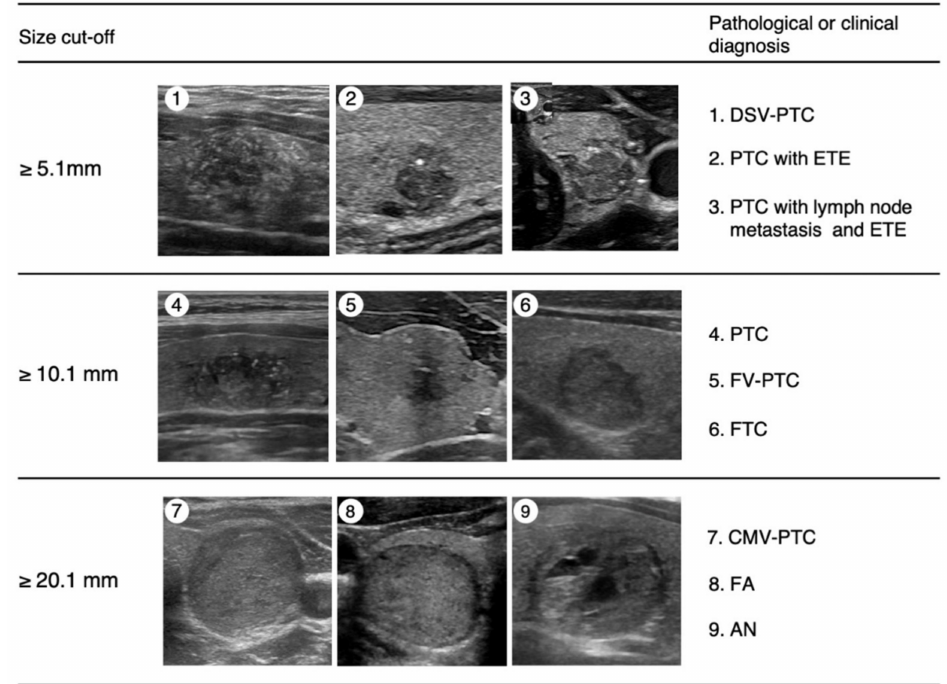
Figure 2. Cut-off sizes of nodules for FNAC and corresponding representative ultrasound images. Images (1–3): Representative ultrasound images of nodules for which FNAC is recommended at a diameter of 5.1 mm or greater. All images exhibited an irregular shape, ill-defined and jagged border, low and heterogeneous internal echo level, and fine strong echoes. Images (4–6): Representative ultrasound images of nodules for which FNAC is recommended at a diameter of 10.1 mm or greater. Image (4) shows a jagged border, low internal echo level, and multiple fine strong echoes; image (6) shows an ill-defined border and fine and coarse strong echoes; image (7) shows a jagged border and irregular marginal hypoechoic zone. Images (7–9): Representative ultrasound images of nodules for which FNAC is recommended at a diameter of 20.1 mm or greater. Images (7,8) show no malignant findings; image (8) shows a spongiform pattern and ill-defined border. Pathological or clinical diagnoses in each image are shown in the right column. PTC, papillary thyroid carcinoma; DSV-PTC, cribriform-morular variant of PTC; ETE, extrathyroidal extension; FV-PTC, follicular variant of PTC; FTC, follicular carcinoma; CMV-PTC, cribriform-morular variant of PTC; FA, follicular adenoma; AN, adenomatous